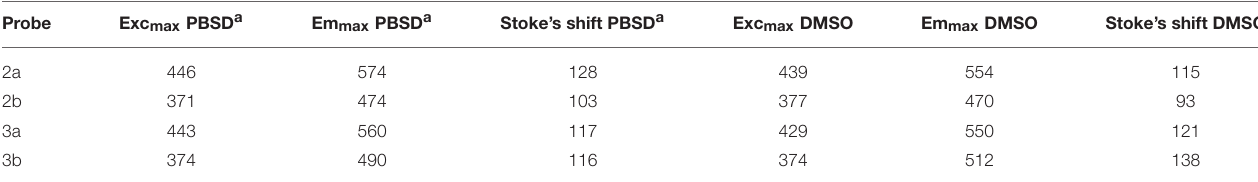
TABLE 1 | Excitation- and emission maxima of probes 2a,b and 3a,b in PBSD a and DMSO.